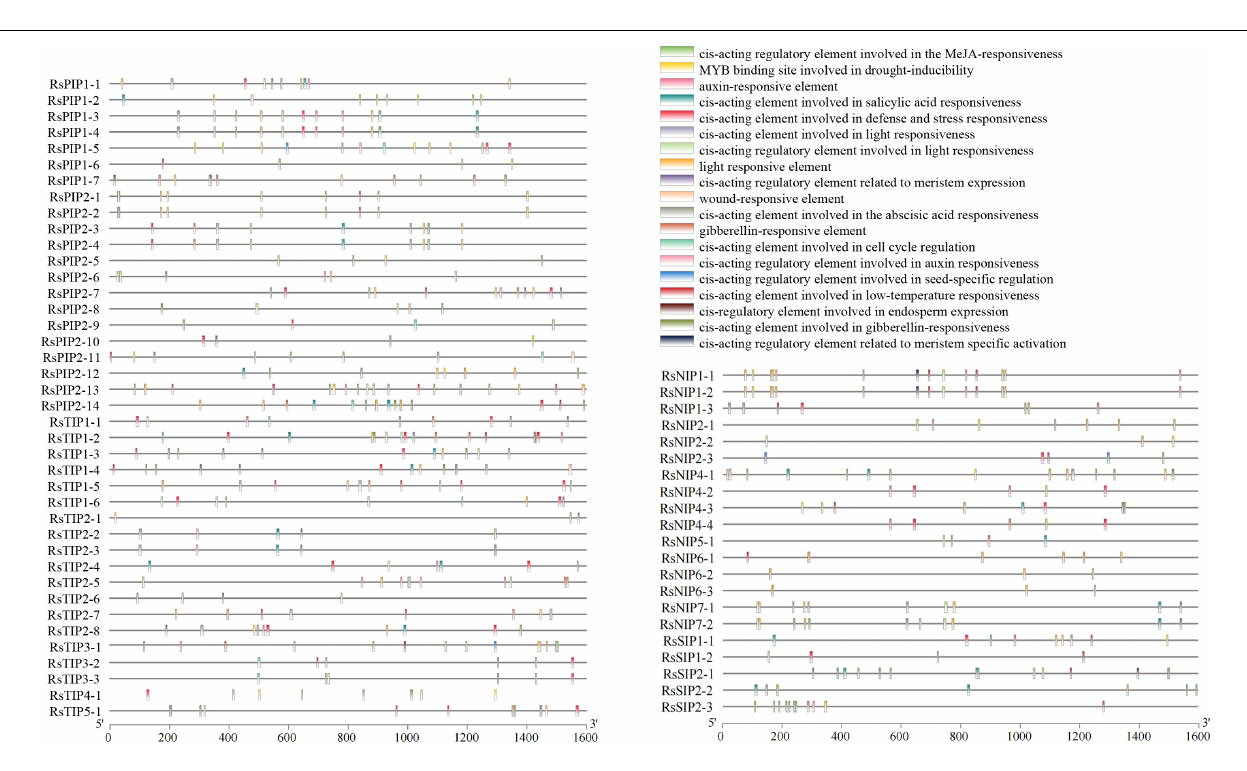
FIGURE 3 | Promoter cis -element prediction of RsAQP